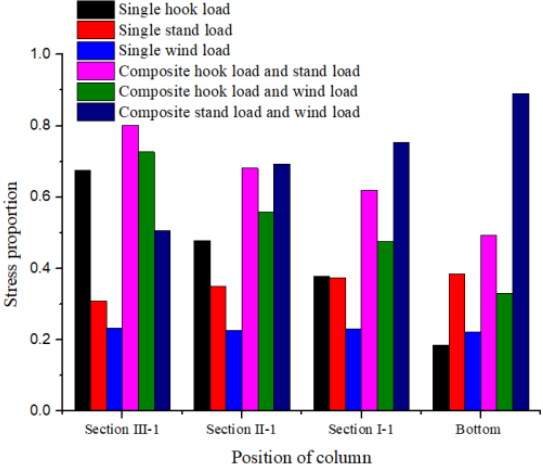
Figure 11. Stress proportion under each load condition.